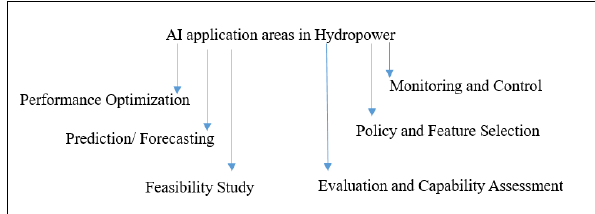
Figure 3. AI application areas in